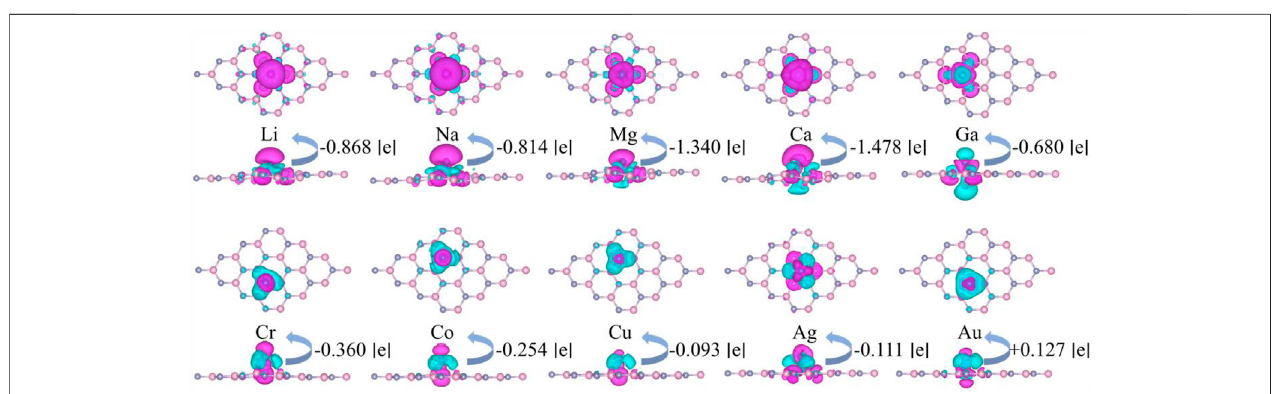
FIGURE 2 | The differential charge density of M or TM adsorbed g-ZnO systems. The blue area and purple area represent electron aggregation and electron dissipation, respectively. And the iso-value is set as 5 × 10 − 4 e Å − 3 .